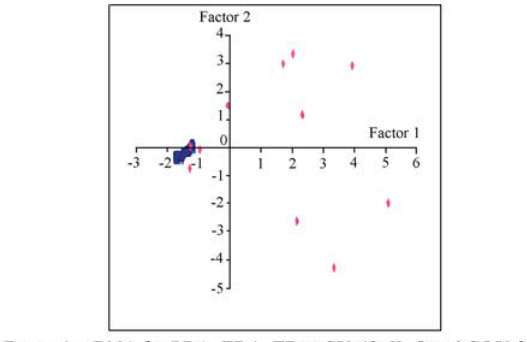
Figure 3. Principal Component Analysis of Messenger RNA Abundances in Human Myometrium Labouring subjects are shown by diamonds and non-labouring by squares. DOI: 10.1371/journal.pcbi.0010019.g003